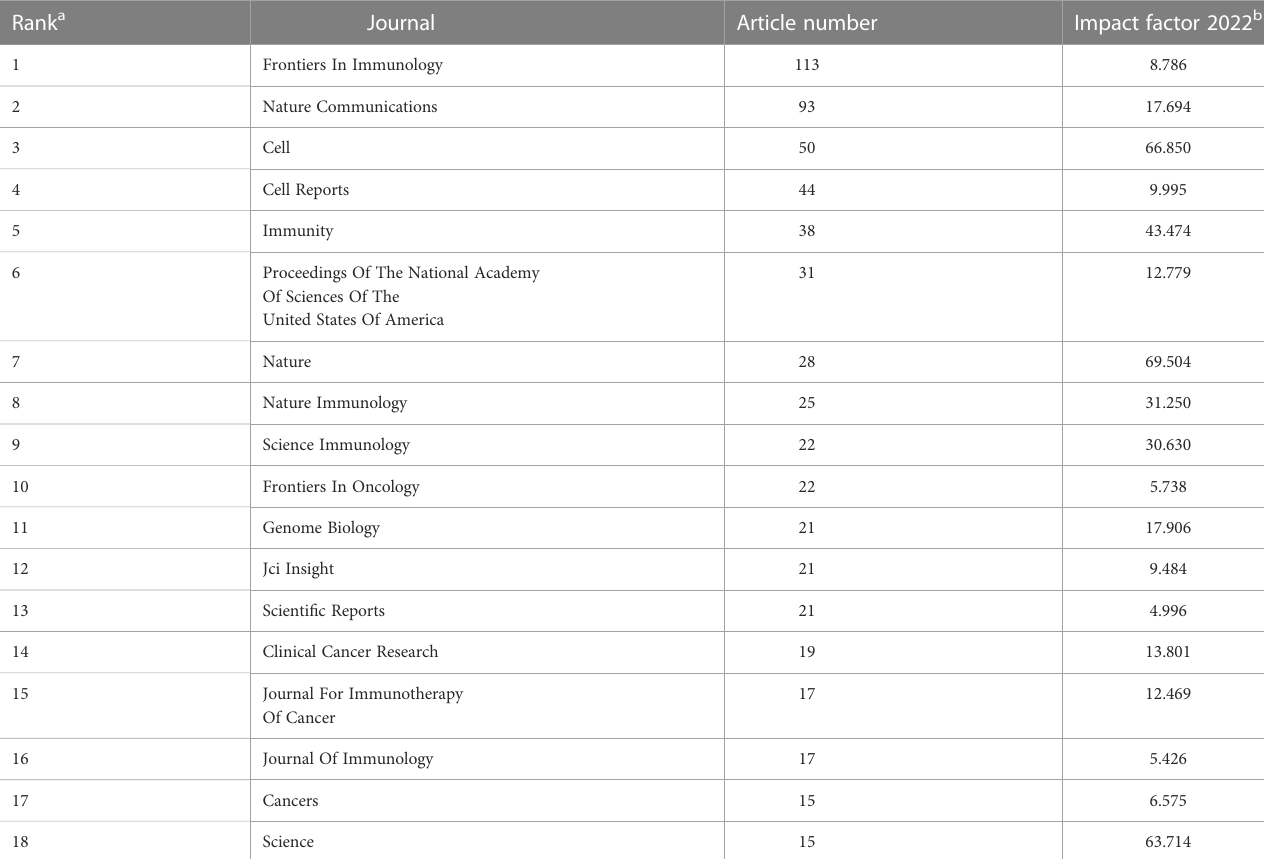
TABLE 1 Top 18 journals of the 1460